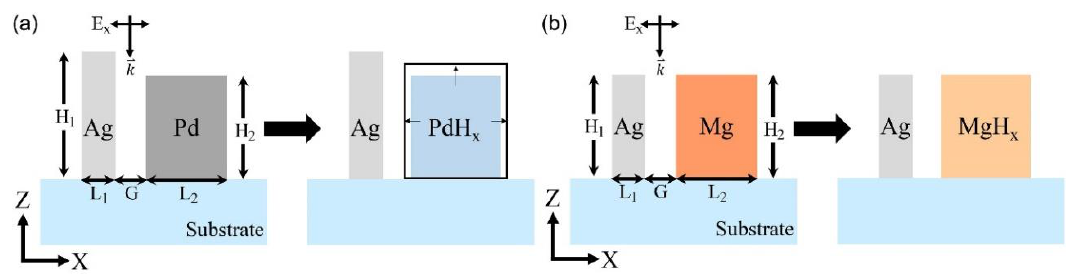
Figure 1. Schematic of hydrogen sensor structures. ( a ) This structure consists of a silver (Ag; H 1 = 230 nm, L 1 = 50 nm) and a palladium (Pd) block (H 2 = 200 nm, L 2 = 150 nm) with a 50 nm gap (G = 50 nm). When the Pd absorbs hydrogen, the Pd lattice expands. ( b ) This structure consists of an Ag (H 1 = 200 nm, L 1 = 50 nm) and a magnesium (Mg) block (H 2 = 200 nm, L 2 = 150 nm) with a 50 nm gap (G = 50 nm). When the Mg absorbs hydrogen, it becomes magnesium hydride (MgH x ), which is a dielectric